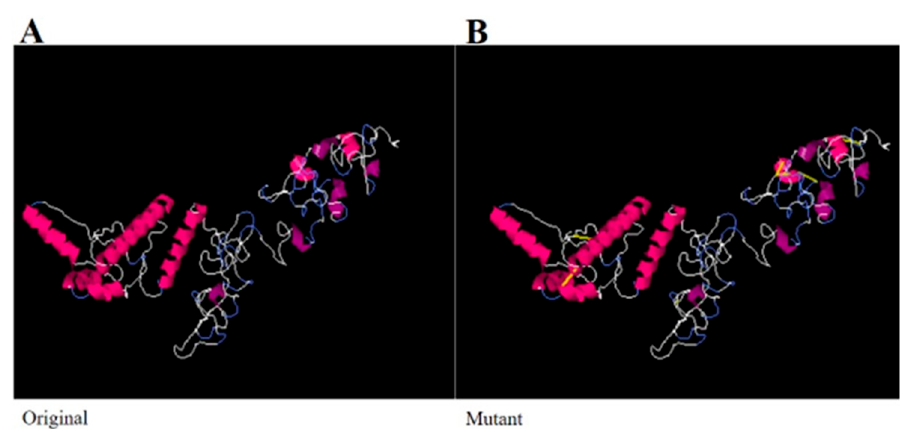
Figure 7. ( A ) Original wild structure of the vaccine construct and ( B ) mutated structure of the vaccine. The yellow sticks are the disulfide bonds introduced via disulfide